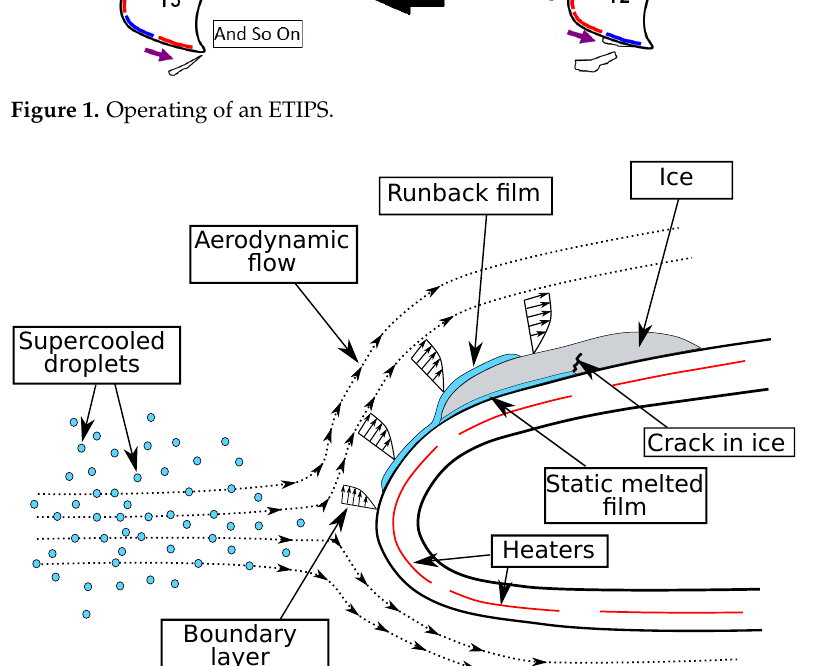
Figure 2. Illustration of the different physical phenomena taking place when an electrothermal ice protection system is being